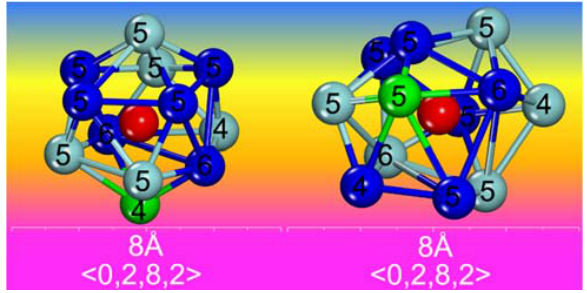
Figure 5. Configurations of two VCs extracted from the RMC ‐ simulated model of Cu 46 Zr 42 Al 7 Y 5 , with the same <0,2,8,2> index. The number labeled on each shell atom stands for the number of its neighbor (connected) shell atoms, also indicates the i ‐ fold symmetry. The blue, celadon, red, and green balls stand for Cu, Zr, Y, and Al atoms, respectively.